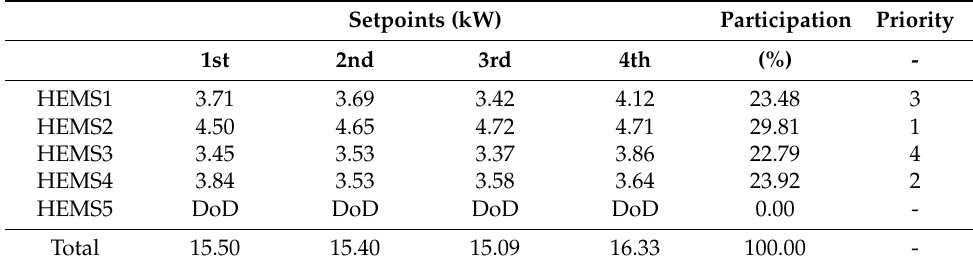
Table 7. Setpoints and priority for the